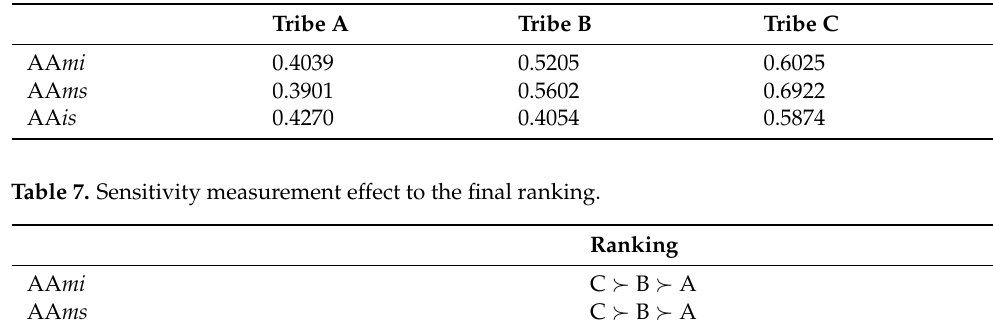
Table 6. The relative approximation values.